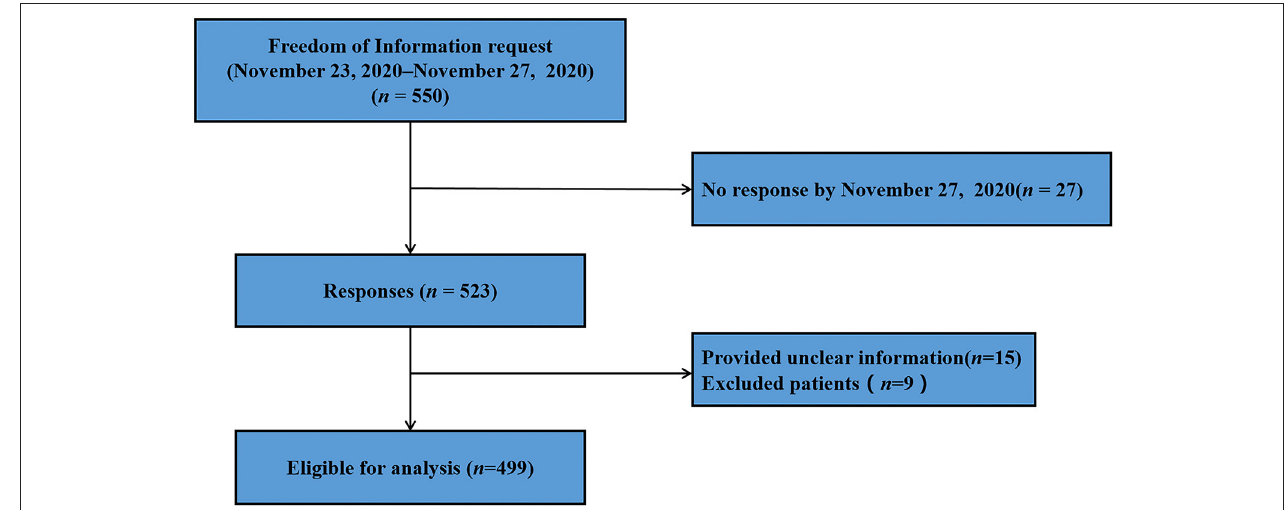
FIGURE 1 | Flowchart of the study population